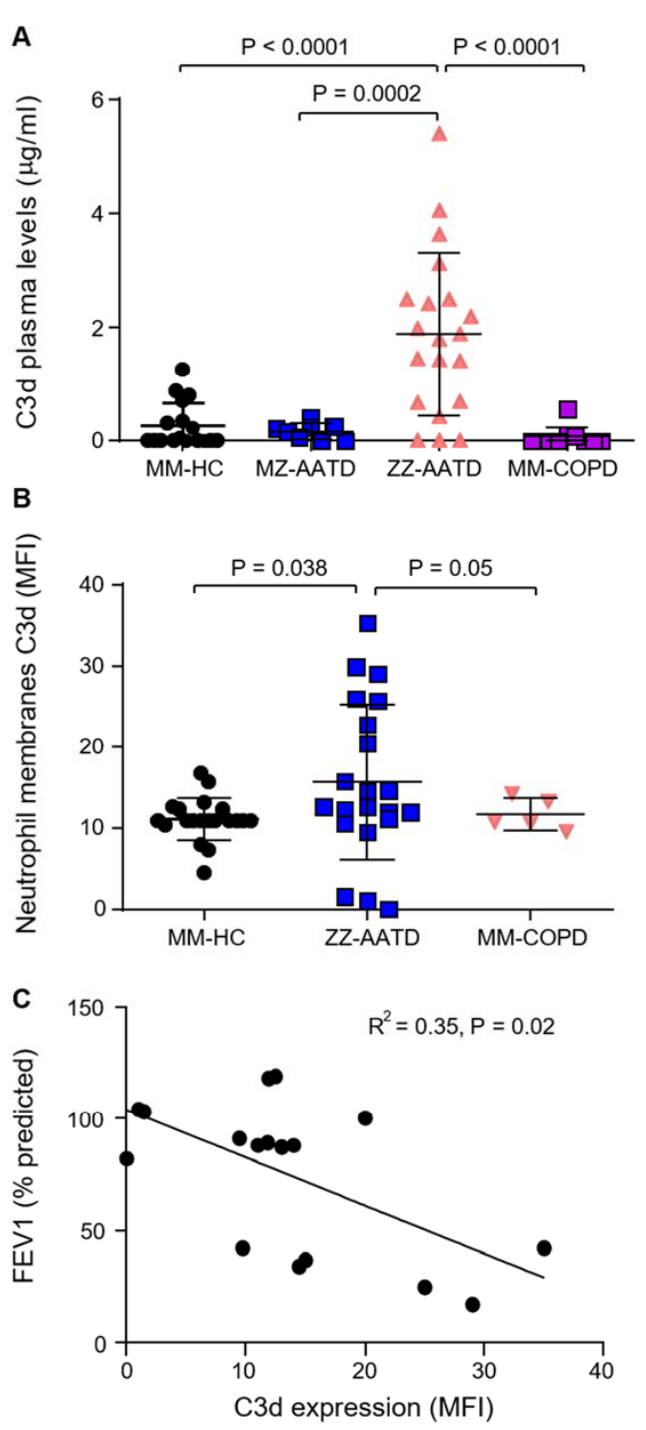
Figure 1. Measurement of C3d in AATD patients. ( A ) Quantification of C3d was performed in the plasma of ZZ-AATD ( n = 20), MZ-AATD ( n = 8), FEV1 matched MM-COPD ( n = 10), and MM-HC individuals ( n = 17) by ELISA. The mean C3d concentration was increased in ZZ-AATD individuals compared to COPD, MZ individuals, and MM-HC individuals. ( B ) C3d levels were measured on the surface of neutrophil membranes isolated from ZZ-AATD ( n = 21), FEV1-matched MM-COPD patients ( n = 5) and MM-HC individuals ( n = 20) by flow cytometry. Statistical analysis was performed using a Mann–Whitney U test. ( C ) A significant inverse correlation was found between C3d neutrophil membrane expression levels and FEV1 (% predicted) values in ZZ-AATD individuals (R 2 = 0.35, p =